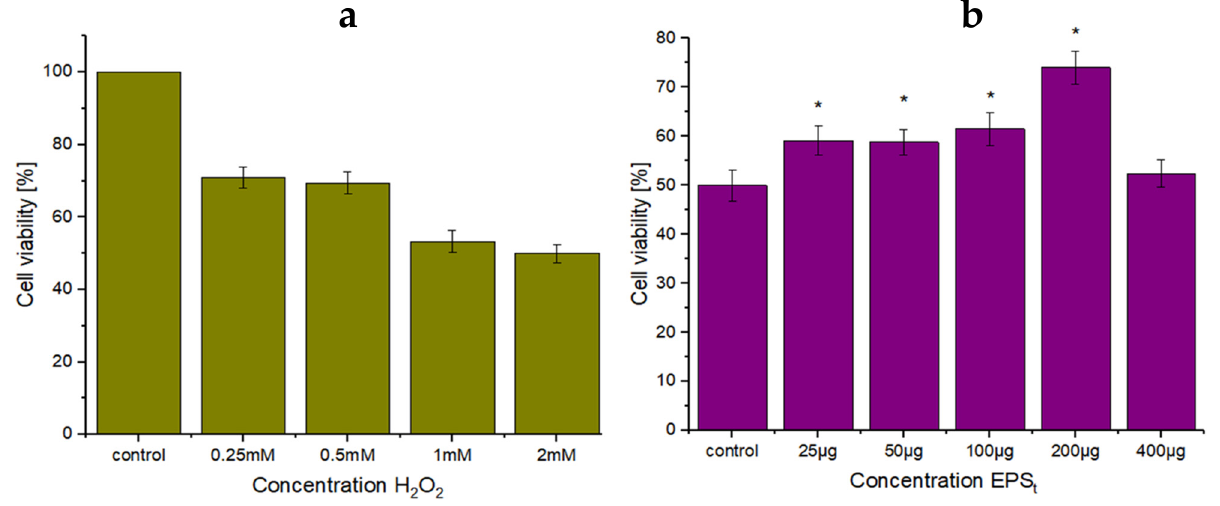
Figure 7. ( a ) HeLa cells viability (%) against oxidative stress by different H 2 O 2 concentrations. ( b ) Exhibition of EPS t protection on HeLa cells viability (%). (n = 3, significant differences * p < 0.05.)